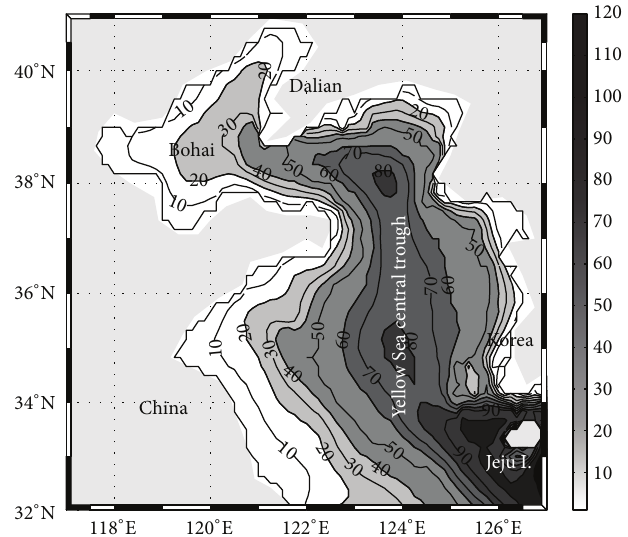
Figure 1: Bottom topography of the Yellow Sea